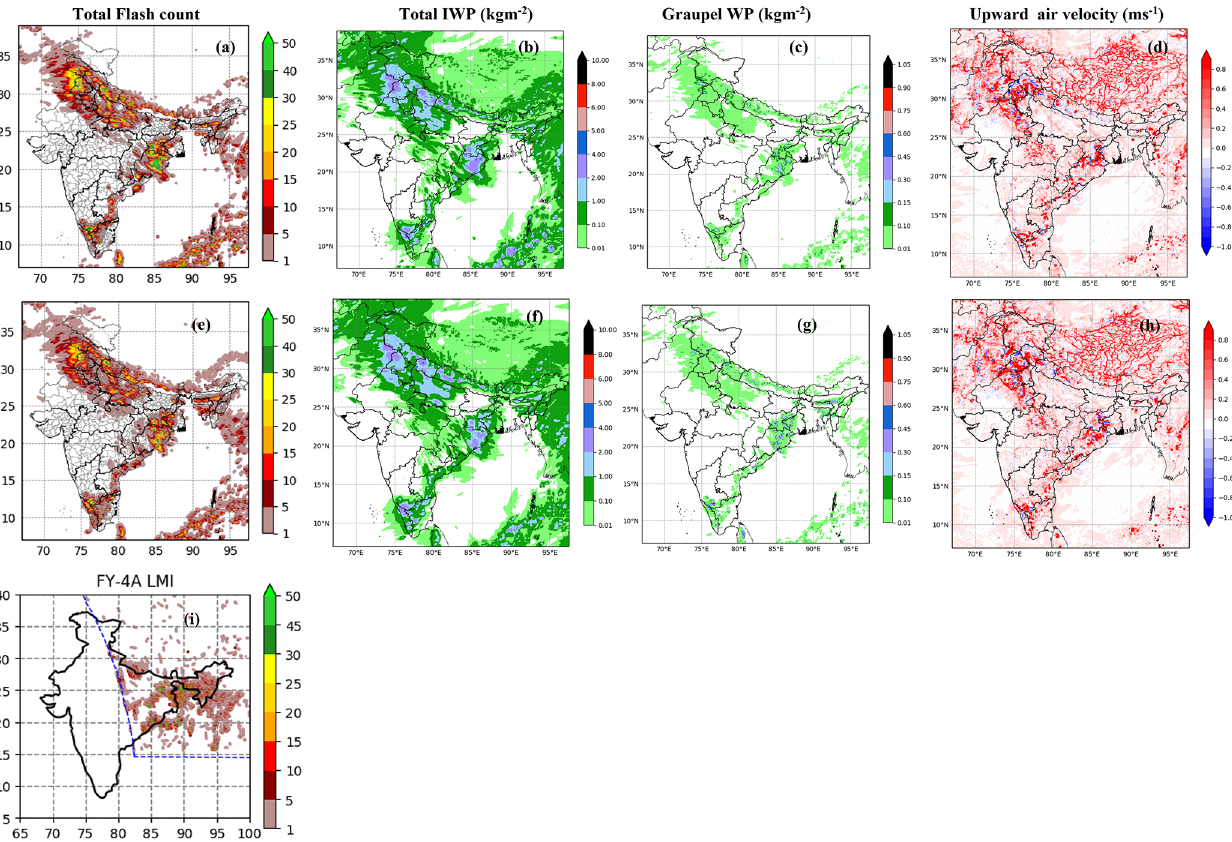
Figure 14. NCMRWF 2 May 2018 lightning case study: RAL1 (top) and RAL2 (middle). Panels (a) – (e) are total lightning flashes, panels (b) – (f) are total ice water path, panels (c) – (g) are total graupel water path, and panels (d) – (h) are vertical velocity at 500hPa. Panel (i) is accumulated lightning flash counts from FY-4A LMI